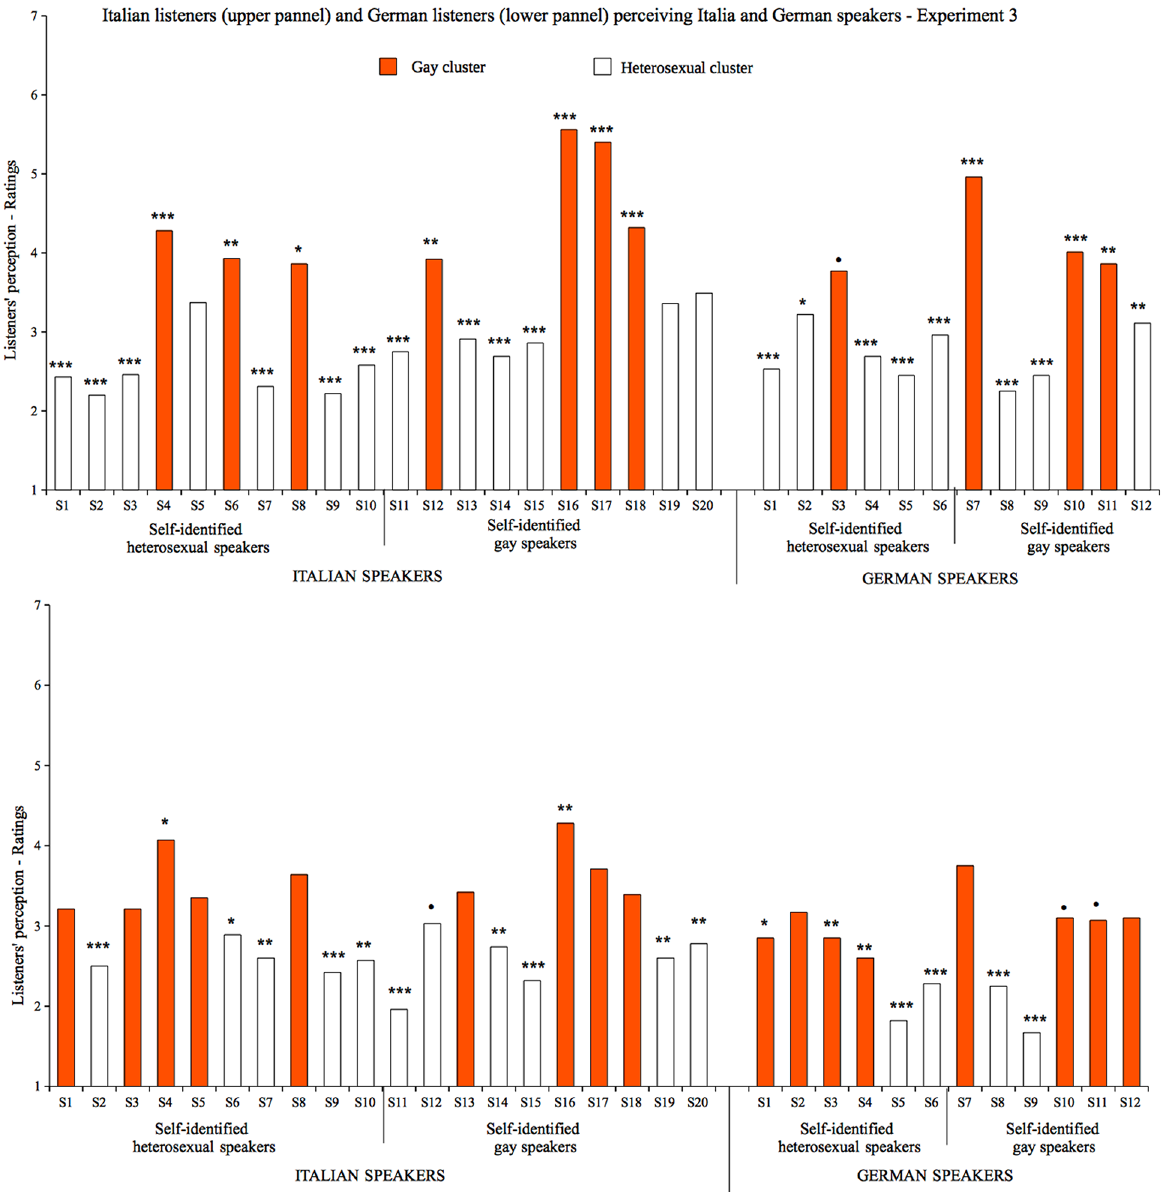
Fig 5. Italian (upper part) and German (lower part) listeners – in terms of ratings (Experiment 3) – of Italian and German speakers. Different colors indicate the two clusters according to listeners perception. Stars (and points) indicate those speakers significantly perceived either as heterosexual or gay (. < .1; * < .05; ** < .01; *** < .001). Higher values of the y-axis indicate perceived gayity, lower values perceived